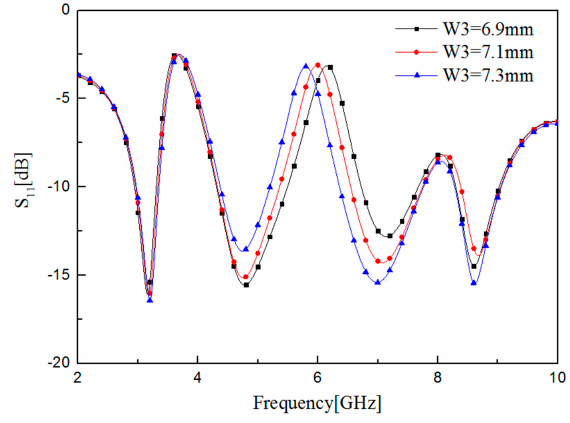
Figure 5. Effect of parameter R 1 on the simulated return loss.